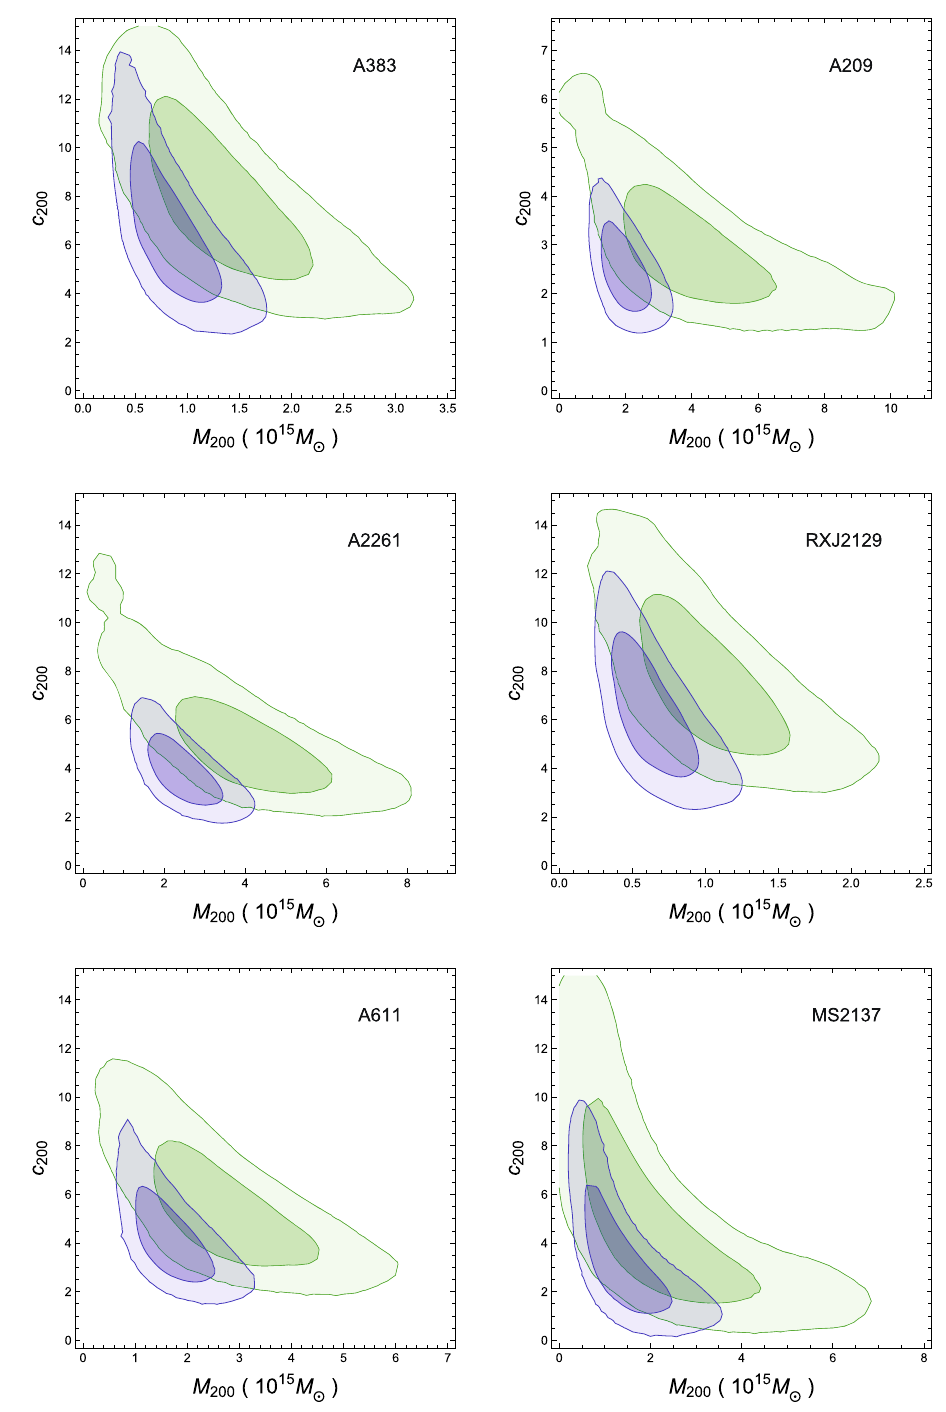
Fig. 3 Contour plot: blue—GR;